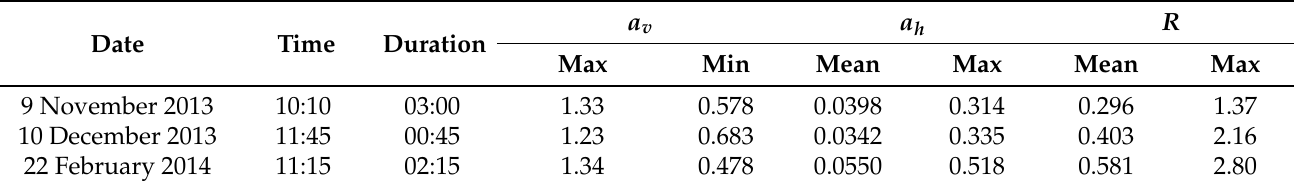
Table 3. Accelerations and maximum magnitude of rotational rate for three control data sets. Although these data sets contain steep waves and incipient breakers, they contain no spilling or plunging breakers. Vertical and horizontal acceleration are given in units of acceleration/g as a v and a h , respectively. The magnitude of rotational rate in pitch and roll is given in units of rad/s as R